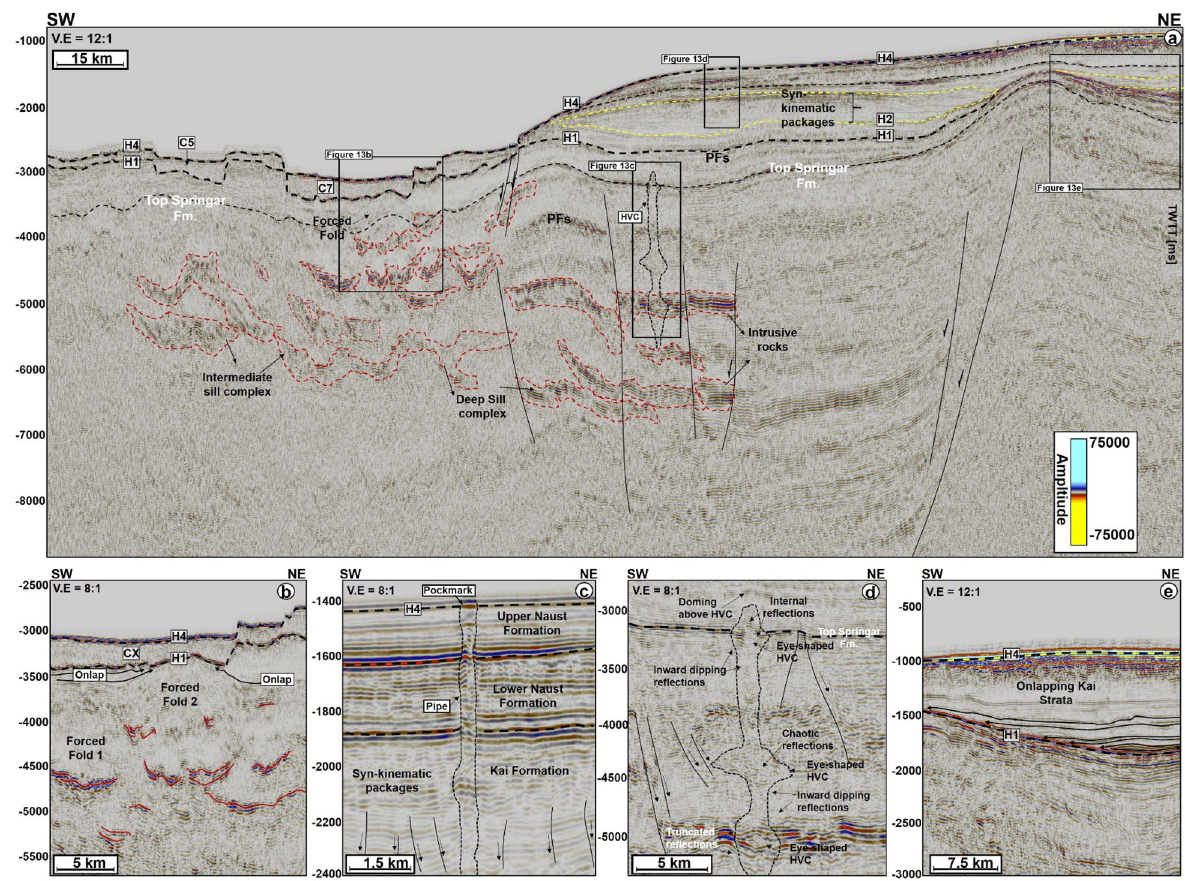
Figure 12. ( a ) Regional 2D seismic line showing forced folds and magmatic intrusions in the study area. The seismic line runs between the Solsikke and SMA areas. In addition, the figure shows evidence for ( b ) local uplift caused by magmatic sill emplacement under craters, and ( c ) an example of a vertical fluid-flow structure within the Naust Formation, revealing that vertical fluid seepage is a common phenomenon on the modern seafloor. ( d ) Example of a hydrothermal vent complex below a crater, a character providing evidence for protracted fluid flow in the study area. ( e ) Regional uplift related to basin evolution and dynamics. Onlapping reflections above the Brygge Formation show that the region was uplifted during the